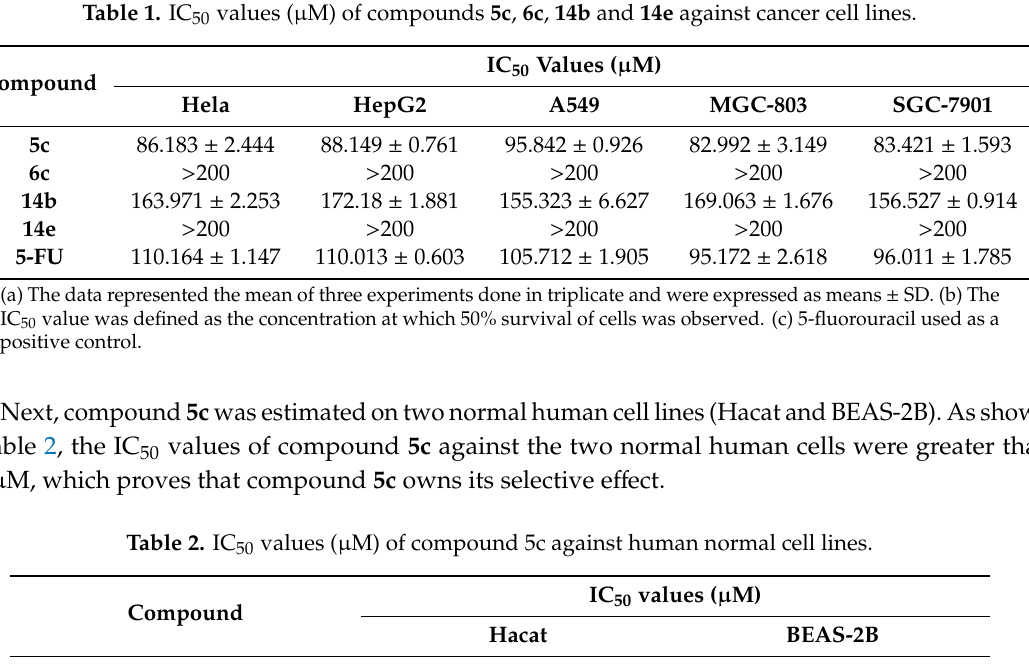
Table 2. IC 50 values ( μ M) of compound 5c against human normal cell lines.